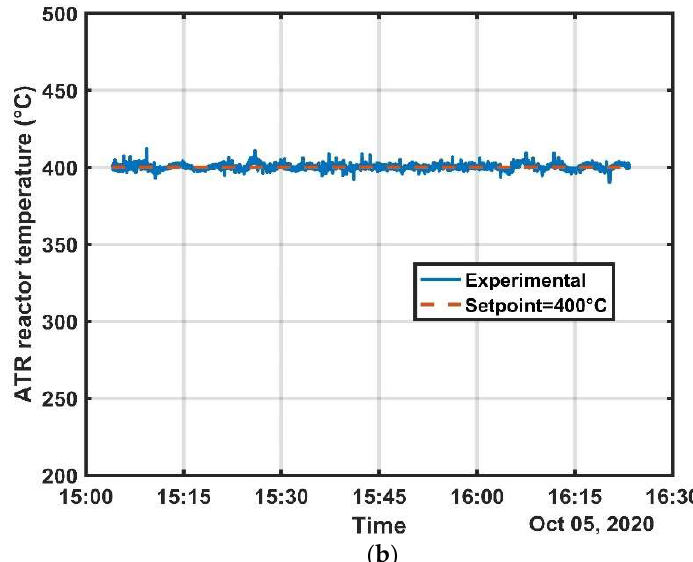
Figure 9. Schematic diagram of the reactor temperature profile (( a ) MPC control; ( b ) PID control).